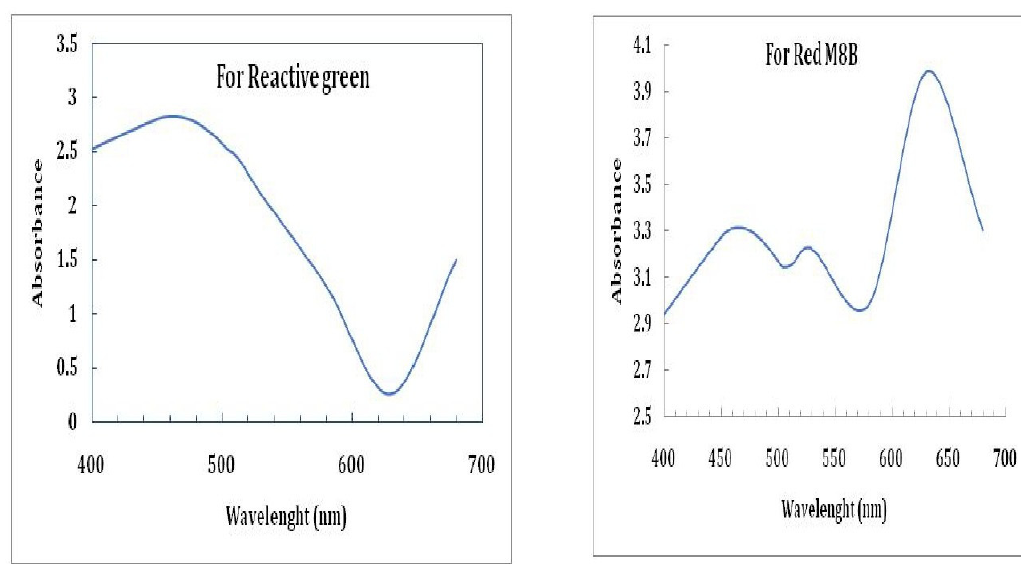
Fig. 13. Absorption Maxima of Red M8B and Reactive Green Dye